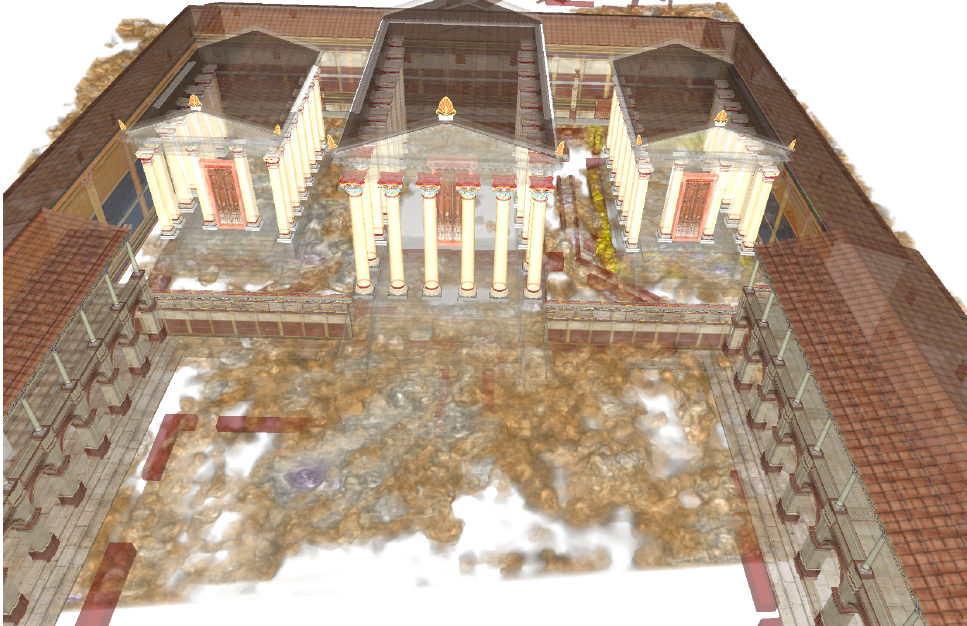
Figure 13. Combined visualization of GPR data, interpretation model, segmentation, and a virtual reconstruction of the Roman forum in Carnuntum. The integration of the 3D model allows viewers with no prior knowledge of Roman architecture to gain an idea of the possible original appearance of the buildings detected by ground penetrating